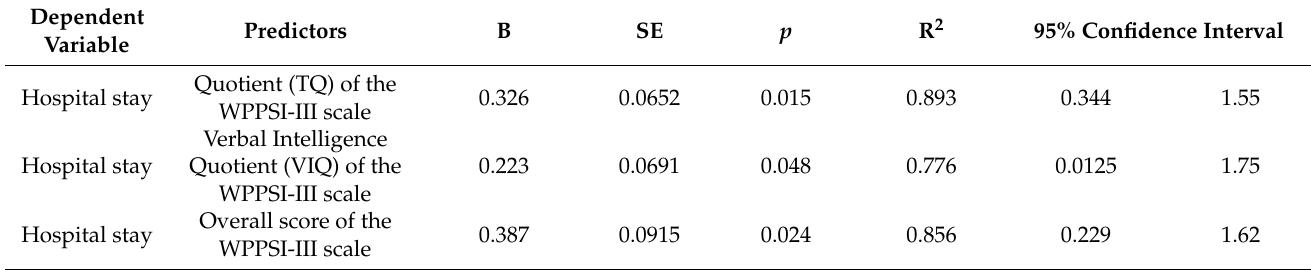
Table 3. Significant linear regression between hospitalization days and WPPSI-III subscales.